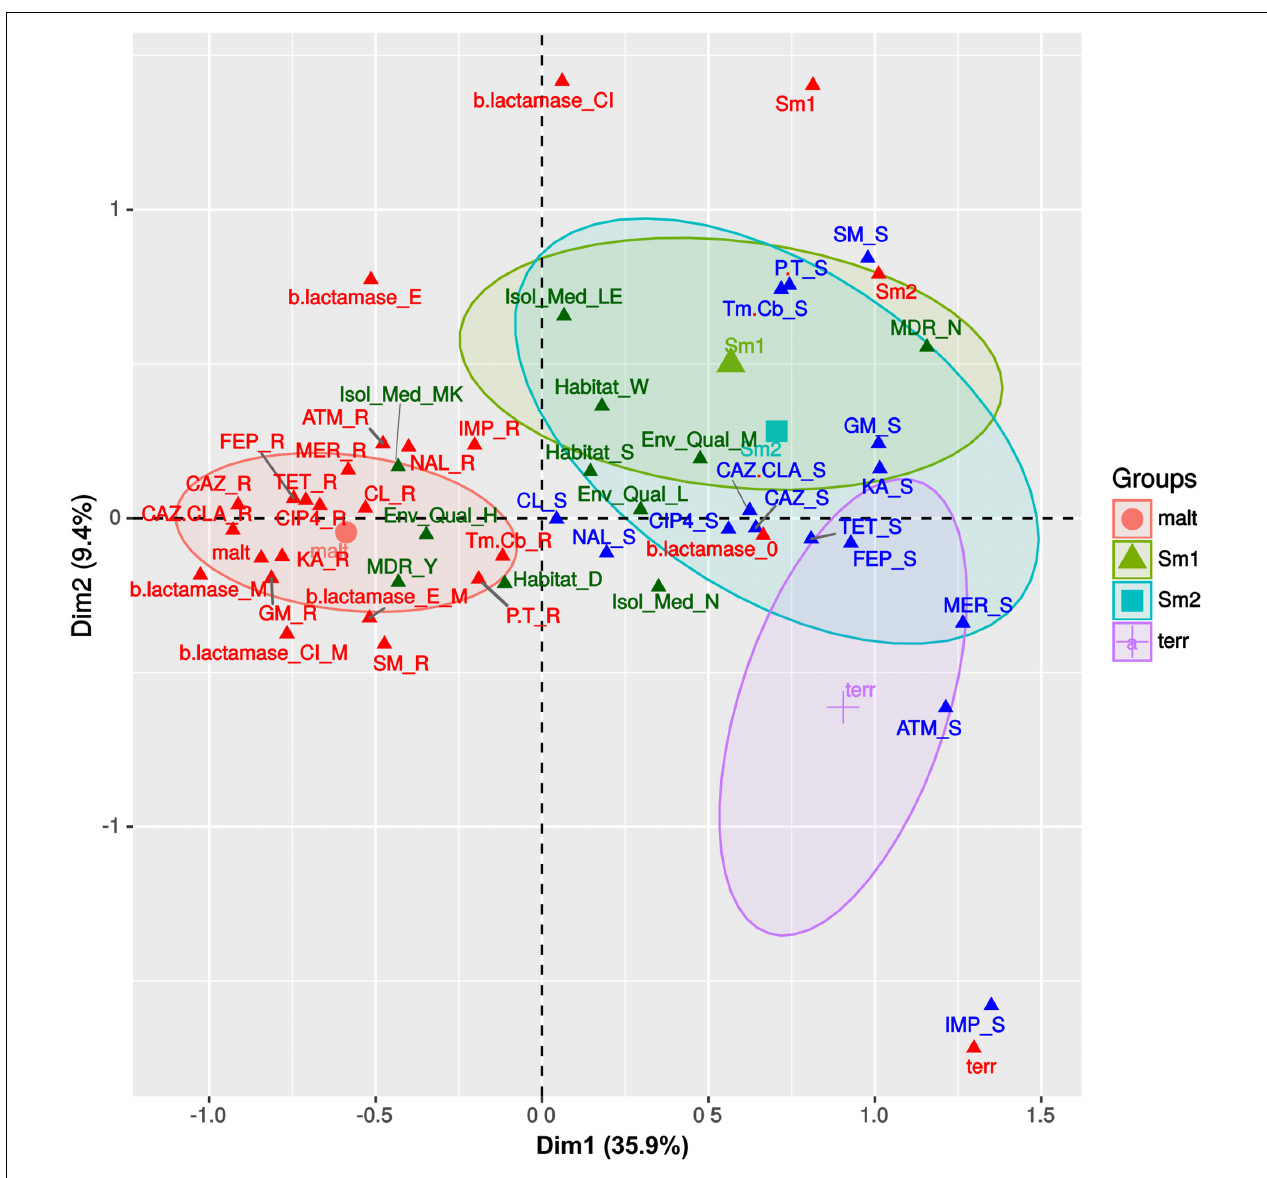
FIGURE 3 | Multivariate correspondence analysis (MCA) factor –individuals biplot map, summarizing the associations between antibiotic resistance profiles, β -lactamase production phenotypes and species assignations. The state of 17 active variables (IMP, imipenem; MER, meropenem; CAZ, ceftazidime; CAZ.CLA, ceftazidime/clavulanate; FEP, cefepime; ATM, aztreonam, b.lactamase, species; Tm.Cb, trimethoprim + carbenicillin; CL, chloramphenicol; SM, streptomycin; GM, gentamicin; KA, kanamycin; P.T, piperacillin/tazobactam; NAL, nalidixic acid; CIP4, ciprofloxacin; TET, tetracycline) and 4 supplementary categorical variables [Habitat, Env_Qual (environmental quality), Isol_Med (isolation medium), MDR] are shown, sorted along the first two dimensions that together explain 45.3% of the total variance. Some variables like CTX4 (cefotaxime) were excluded, due to lack of variability in the observed states. Species name abbreviations are as follows: malt = S. maltophilia ; Sm1 = Smc1; Sm2 = Smc2; terr = S. terrae